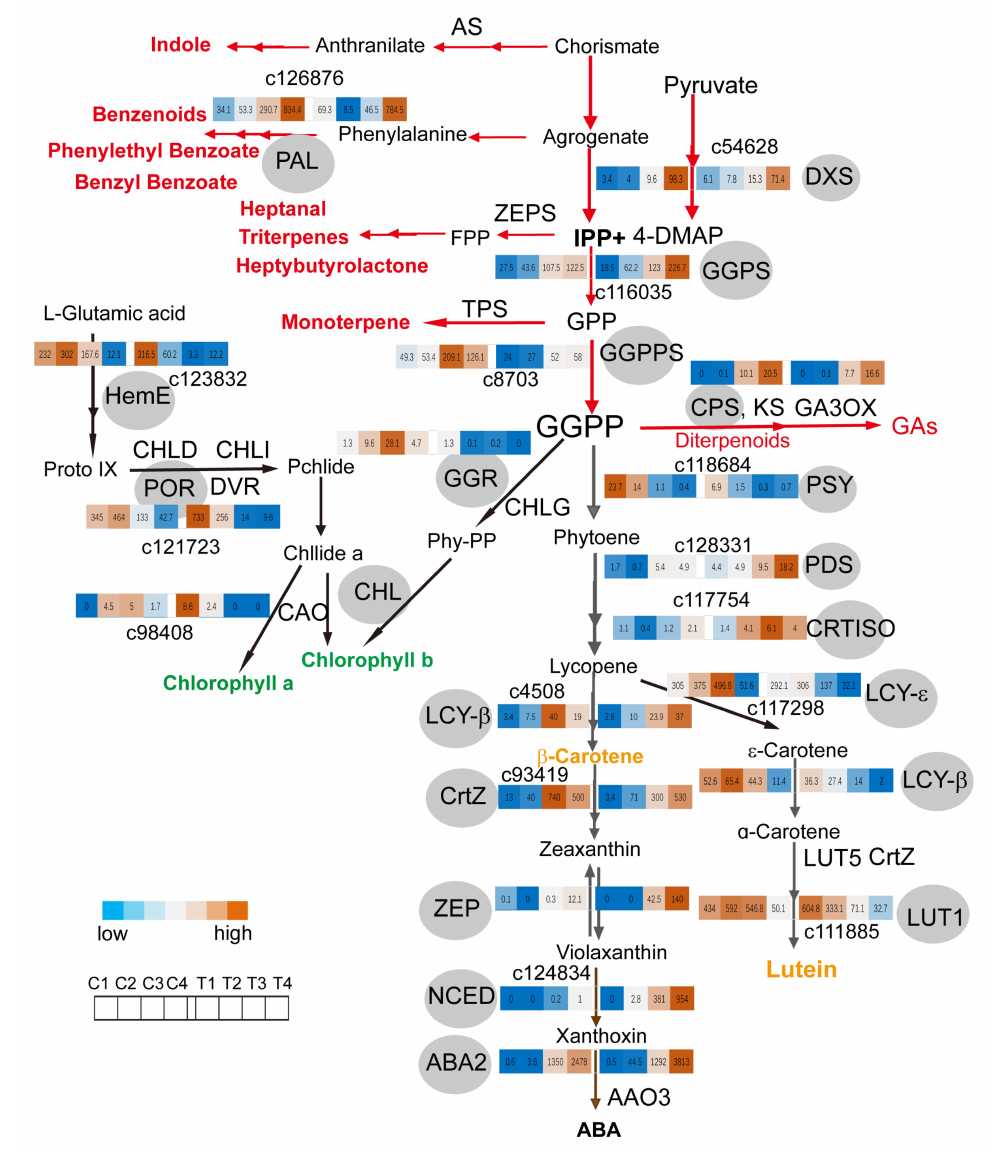
Figure 5. Three branches of MEP pathway include carotenoids biosynthesis, the biosynthesis of the phytol side chain of chlorophylls, and of diterpenoids such as gibberellins in the Narcissus flower. The red line and arrowhead in the up panel represents the terpenoids metabolic pathway, and the black line and arrowhead represents carotenoids biosynthesis; the biosynthesis of the phytol side chain of the chlorophylls pathway. The heat map shows the expression patterns of differentially expressed genes related to three branches of MEP pathway in tepals and coronas at different periods (left down). Enzyme names are shown in the gray background circle. The FPKM values of genes are labeled on the heat map. The color bar from blue to orange is upregulated; from orange to blue is down regulated: AS, anthranilate synthase; ZFPS, cis,cis- farnesyl diphosphate synthase; DXS, 1-deoxy-D-xylulose-5-phosphate synthase; DXR, 1-deoxy-D-xylulose 5-phosphate reductoisomerase; GGPP, geranylgeranyl diphosphate; GGPPS, geranyl diphosphate synthase; TPS, terpene synthase; PSY, phytoene synthase; PDS, phytoene desaturase; ZDS, zeta-carotene desaturase; CRTISO, carotene isomerase; LCY- ε , lycopene epsilon-cyclase; LCY- β , lycopene beta-cyclase; CrtZ, beta-carotene 3-hydroxylase; LUT5, beta-ring hydroxylase; LUT1, carotenoid epsilon hydroxylase; ZEP, zeaxanthin epoxidase; VDE, violaxanthin de-epoxidase; NCED, 9- cis -epoxycarotenoid dioxygenase; ABA2, xanthoxin dehydrogenase; AAO3, abscisic-aldehyde oxidase; GGR, geranylgeranyl reductase; HemL, glutamate-1-semialdehyde 2,1-aminomutase; HemE, uroporphyrinogen decarboxylase; ChlD, magnesium chelatase subunit D; CHLI, magnesium chelatase subunit I; POR, protochlorophyllide reductase; CAO, chlorophyllide a oxygenase; CLH, chlorophyllase; DVR, divinyl reductase; CHLG, chlorophyll/bacteria chlorophyll a synthase; CPS, ent -copalyl diphosphate synthetase; KS, ent -kaurene synthase; GA20OX, gibberellin 20-oxidase; GA3OX, gibberellin